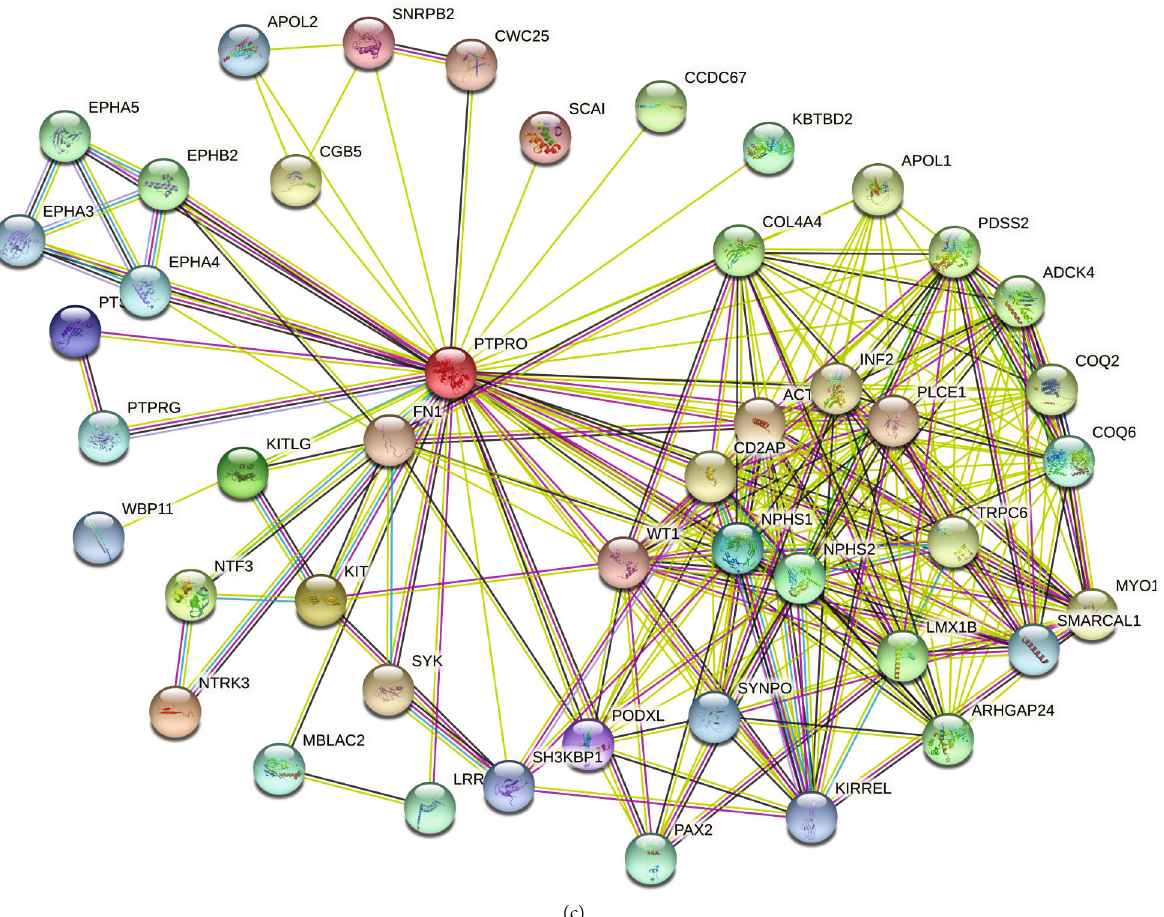
Figure 4: Coexpression network analysis of PTPRO-related genes. (a) Coexpressed genes of PTPRO were analyzed by TCGA-LUAD cohorts. (b) Coexpressed genes of PTPRO were analyzed by GeneMANIA database. (c) Coexpressed genes of PTPRO were analyzed by STRING